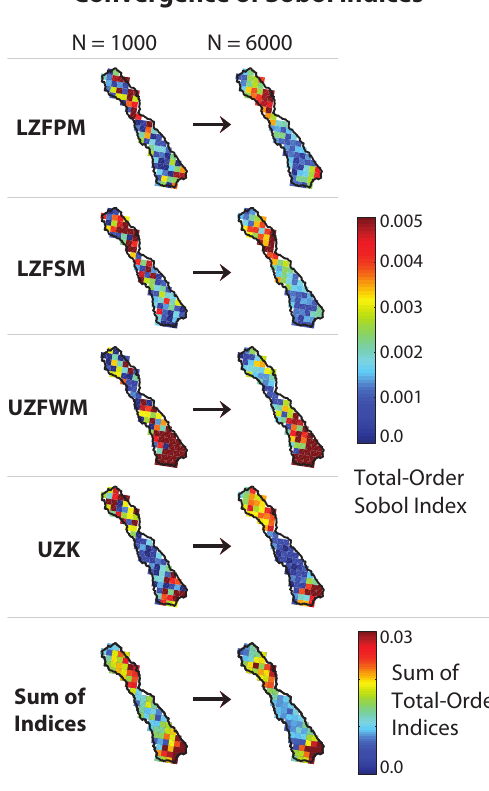
Fig. 3. Maps of the total-order Sobol 0 sensitivity indices for the four most sensitive parameters as well as the total sum in each grid cell. The maps are shown for the N =1000 and N =6000 sample sizes. The lower sample size shows a coarse identification of sensitive and insensitive cells. The N =6000 sample size shows smoother spatial patterns of sensitivity indices, suggesting that this level of sampling is required for reliable Sobol 0